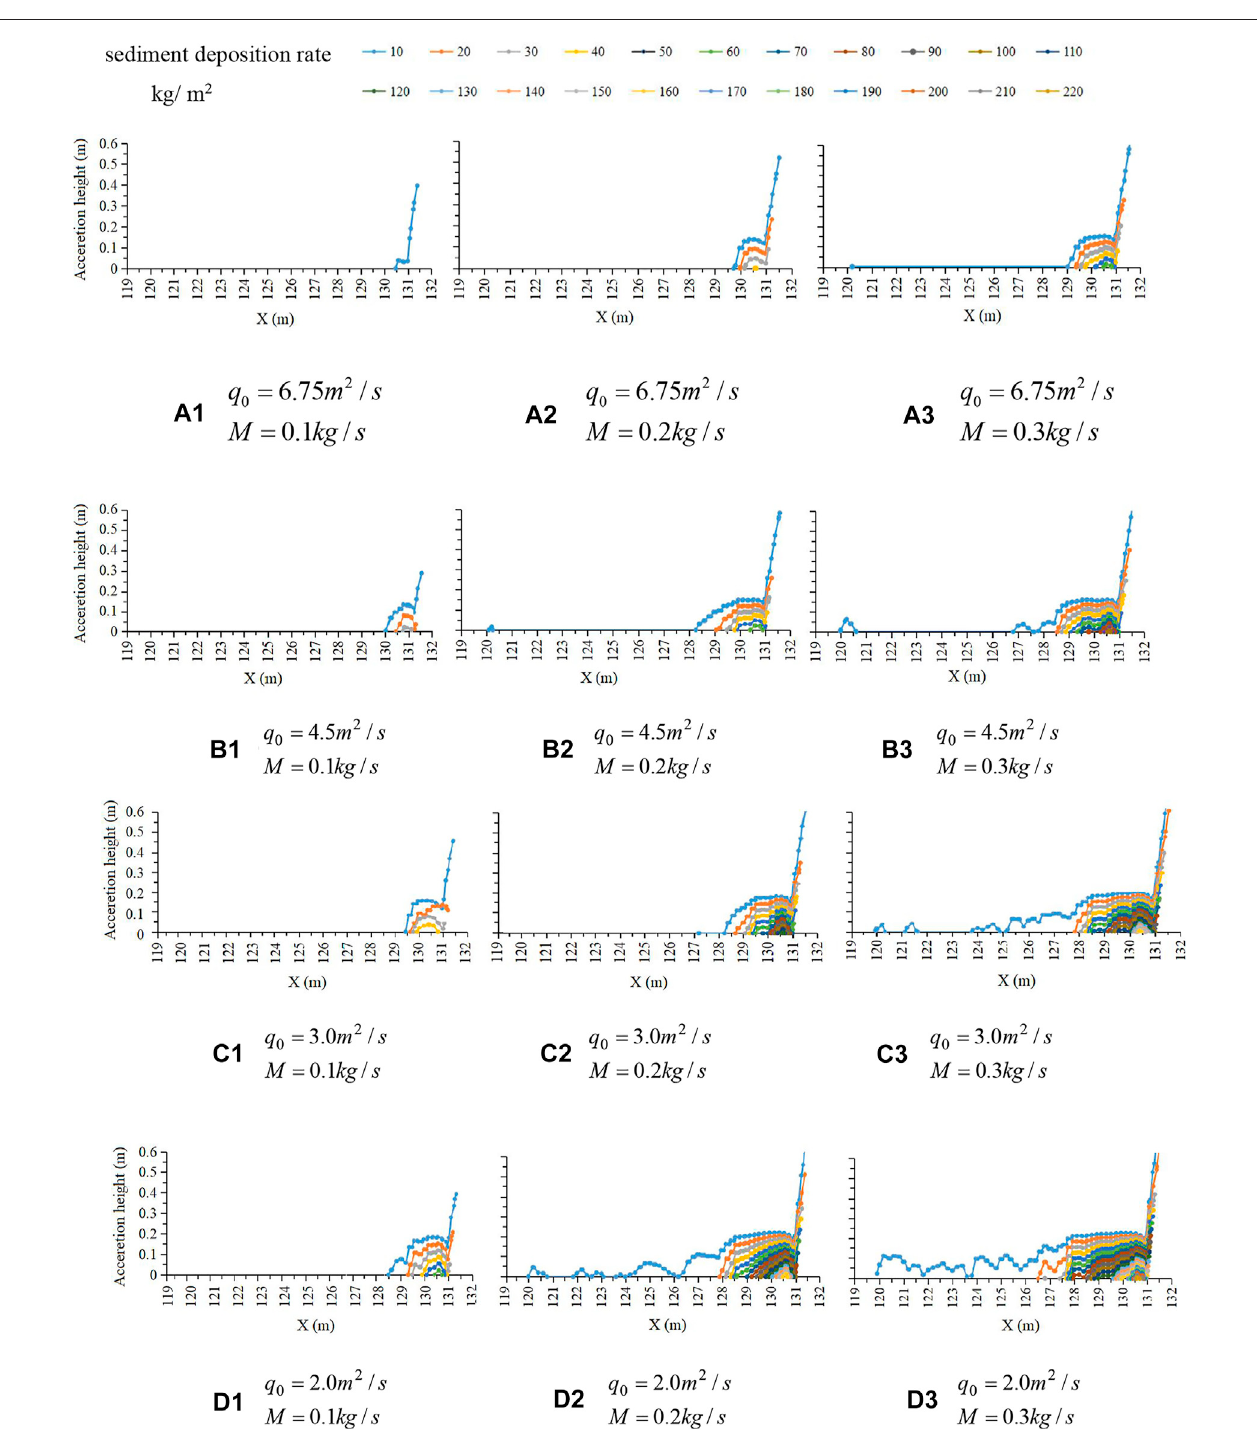
FIGURE 6 | Sediment deposition at the bottom of the stilling basin (A – D) at different inlet unit width fl ows.